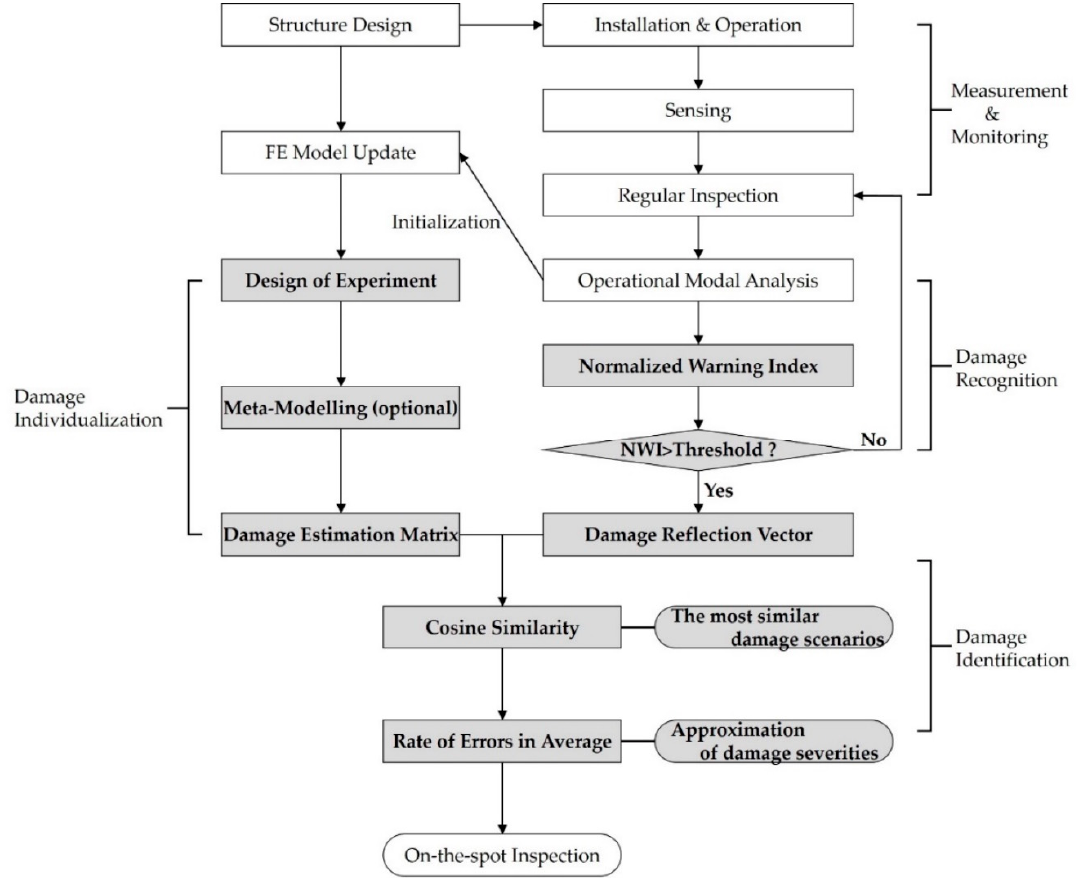
Figure 2. Entire flowchart of cosine similarity-based SHM.